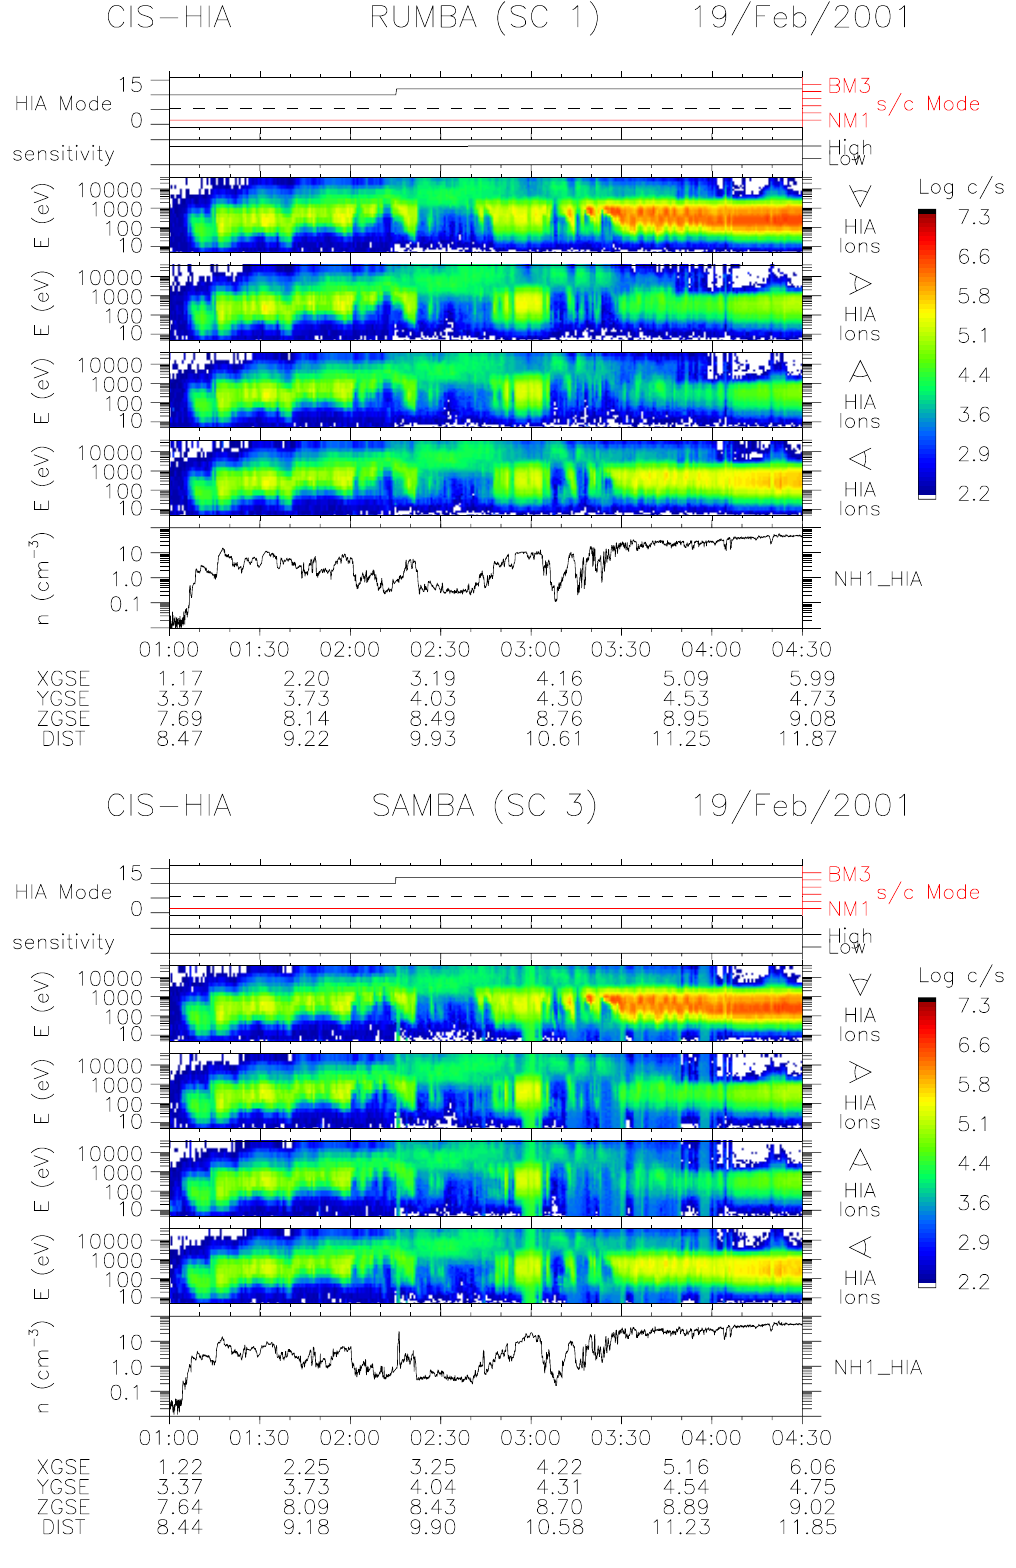
Fig. 33. HIA measurements on board spacecraft 1 and 3, on 19 February 2001, between 01:00 and 04:30UT. Upper panel shows HIA spacecraft 1 measurements and lower panel HIA spacecraft 3 measurements. The two panels show from top to bottom: telemetry modes and sensitivities, energy-time spectrogram measured in the sunward, dusk, anti-sunward, dawnward looking directions, and